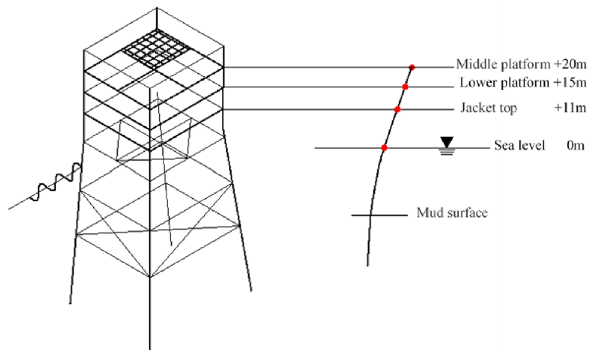
Fig. 11 Diagram of horizontal displacement of jacket platform with different